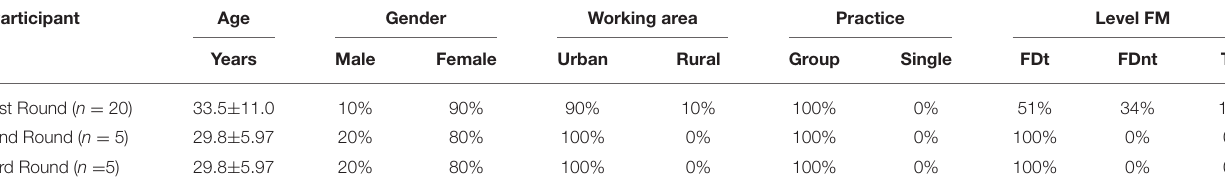
TABLE 1 | Delphi-group participants’ characteristics overview table with gender, age. Participant Age Gender Working area Practice